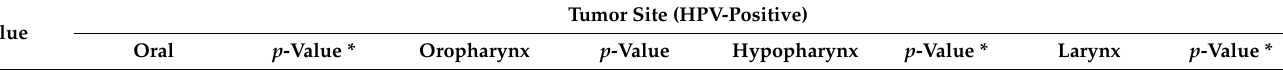
Table 1. Clinicopathological features of HNSCC